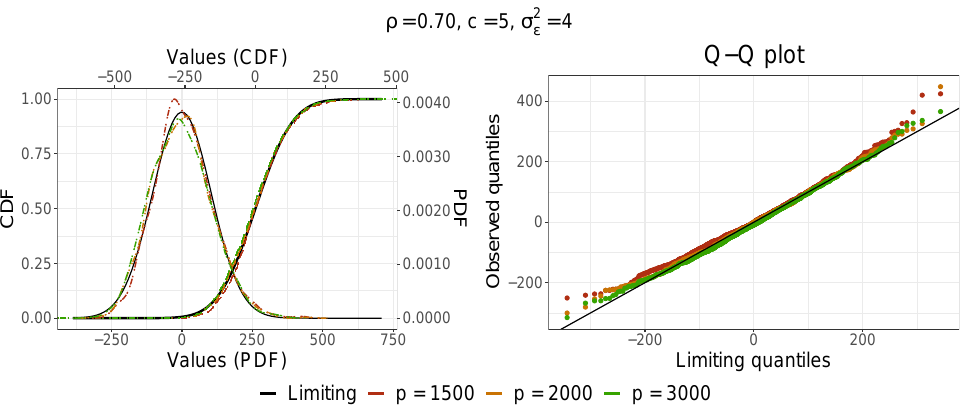
Figure 6. Comparison of the PDF and CDF ( left ) and the corresponding Q-Q plots ( right ) after 1000 replications from the Monte Carlo simulation of the statistic (80) with the limiting distribution N ( 0, s 2 ) by the Corollary 2 (in black) for (cid:36) = 0.7, c = 5, σ 2 = 4 and p = 1500,2000,3000. ε